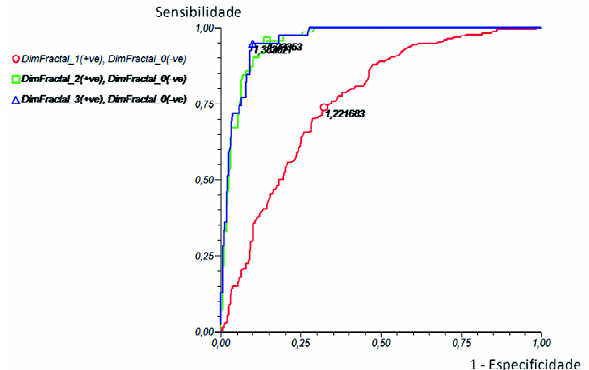
Fig. 2 - Gráfico Curva ROC para diferenciação pela dimensão fractal entre os diferentes graus de rejeição cardíaca (Grau 3 versus 0; Grau 2 versus 0 ; Grau 1 versus